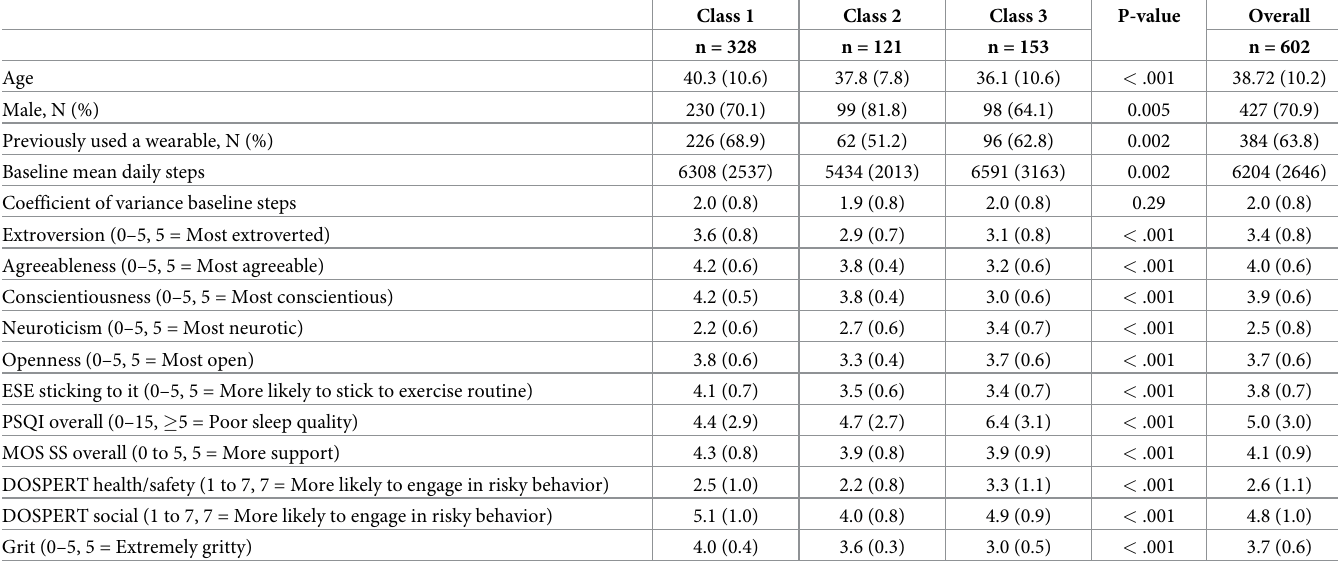
Table 1. Baseline LCA variables in study population and by